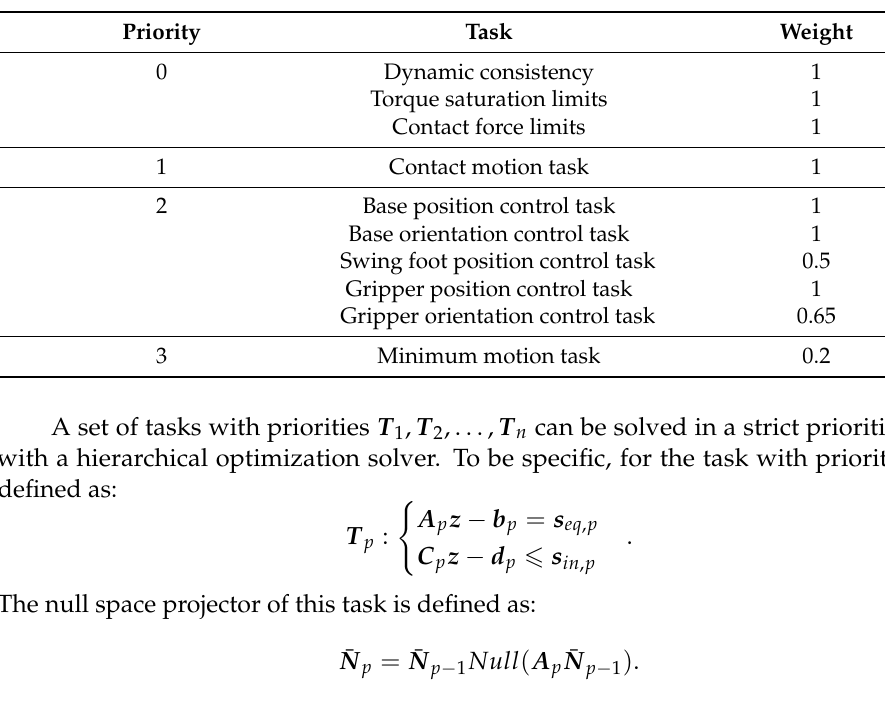
Table 1. Task hierarchy (0 is the highest